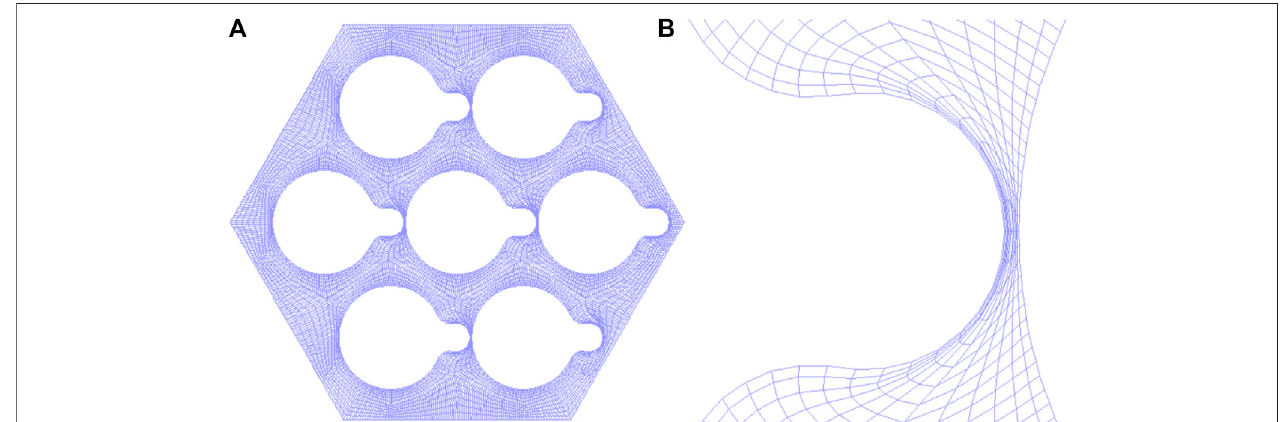
FIGURE 6 | Meshing model for 7-pin wire-wrapped fuel assembly.